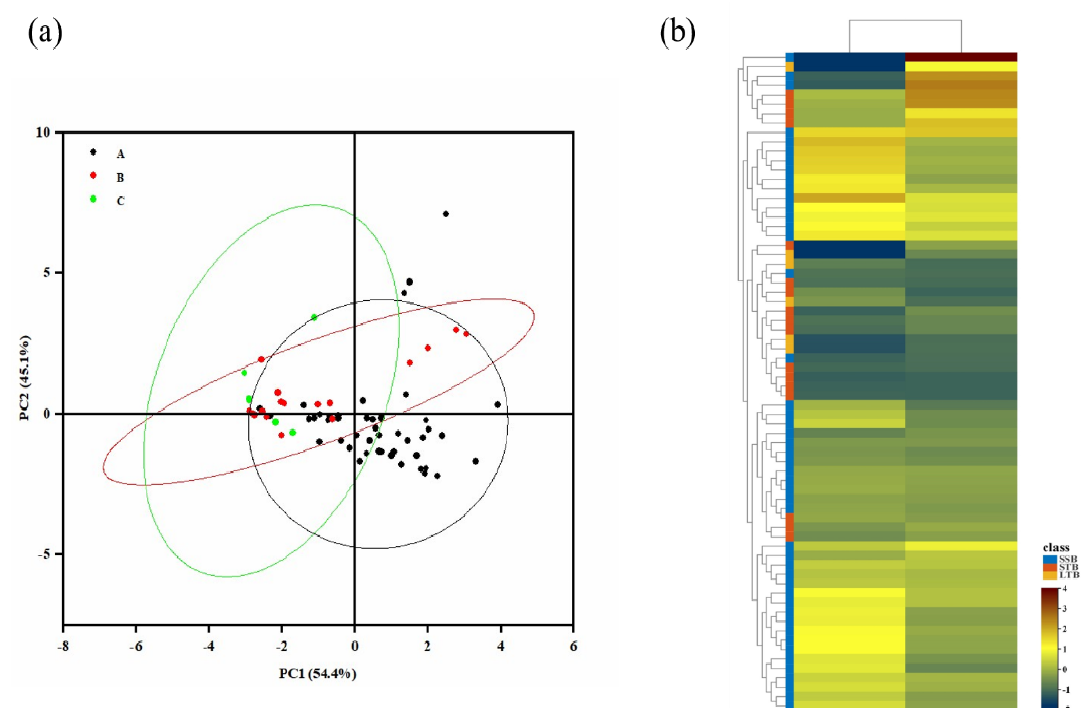
Figure 7. ( a ) Principal component analysis of lactic acid enantiomers in Baijiu samples, A: SSB; B: STB; C: LTB; ( b ) heatmap analysis of lactic acid enantiomers in Baijiu.